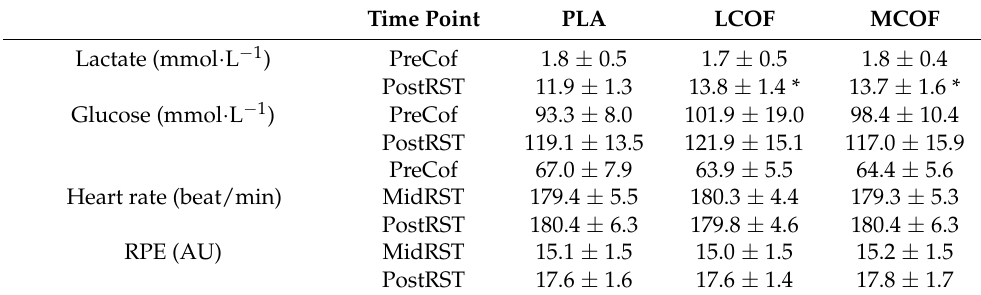
Table 1. Metabolic and physiological parameters assessed during a 12 × 4 s repeated sprint perfor- mance test with ingestion of placebo (PLA) or 3 mg · kg − 1 of caffeine from coffee (LCOF) or 6 mg · kg − 1 of caffeine from coffee (MCOF). Time Point PLA Lactate (mmol · L − 1